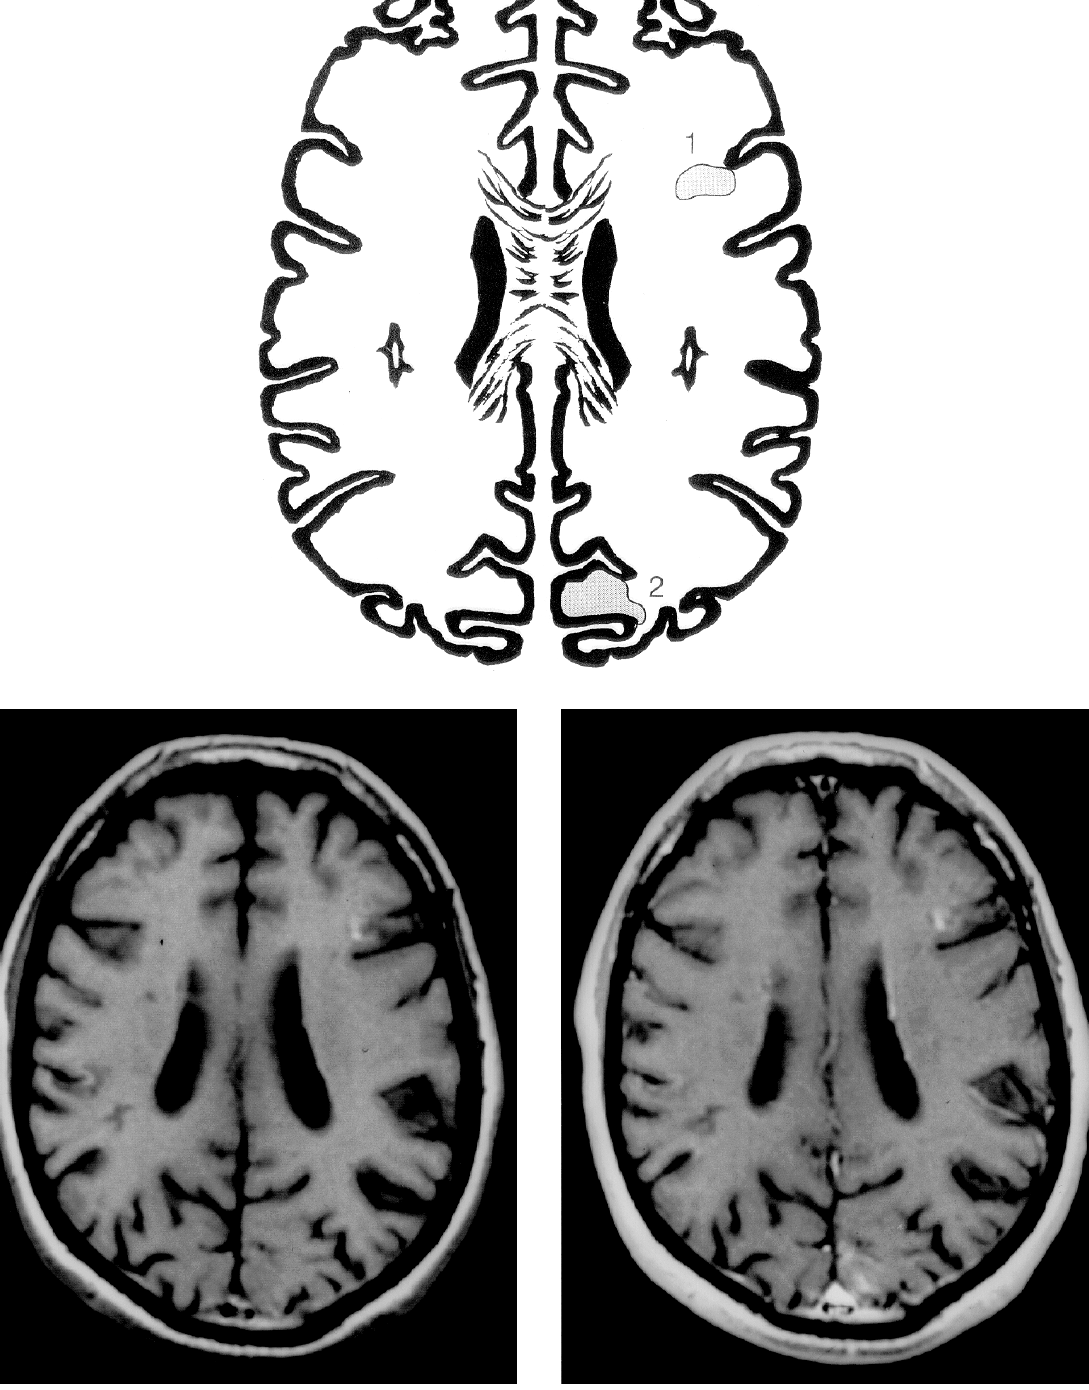
Fig. 1. MRI-scans obtained 9 weeks after the onset of symptoms. Top: According Talairach Slice (slice 113, 24mm superior the commisura anterior-commisura posterior (ac-pc) line); bottom left: T1-weighted images before; bottom right: T1-weighted image after the application of Gadolinium-DTPA. There is a left frontal (No.1) lesion visible. The left hemisphere corresponds to the right side of the